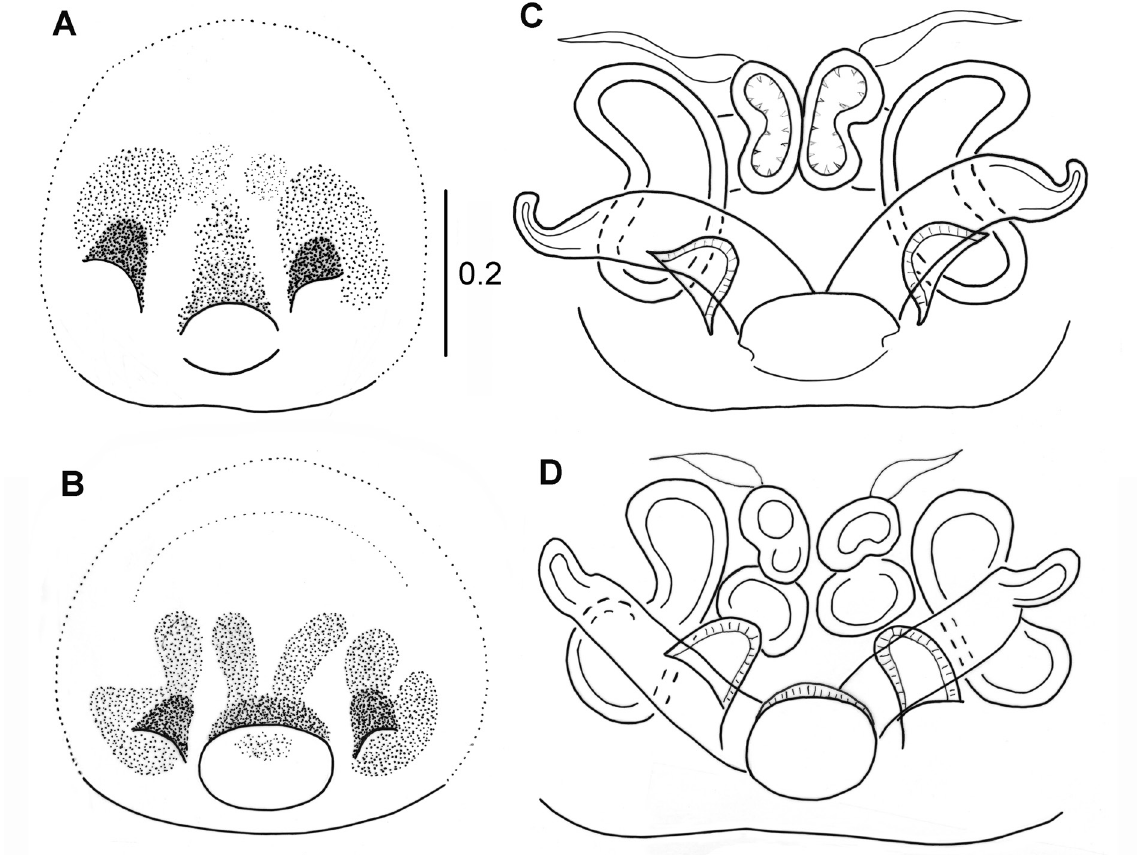
Fig. 30. Iranattus principalis (Wesołowska, 1999), ♀ (MNHN). A–B . Epigyne. C–D . Internal structure of